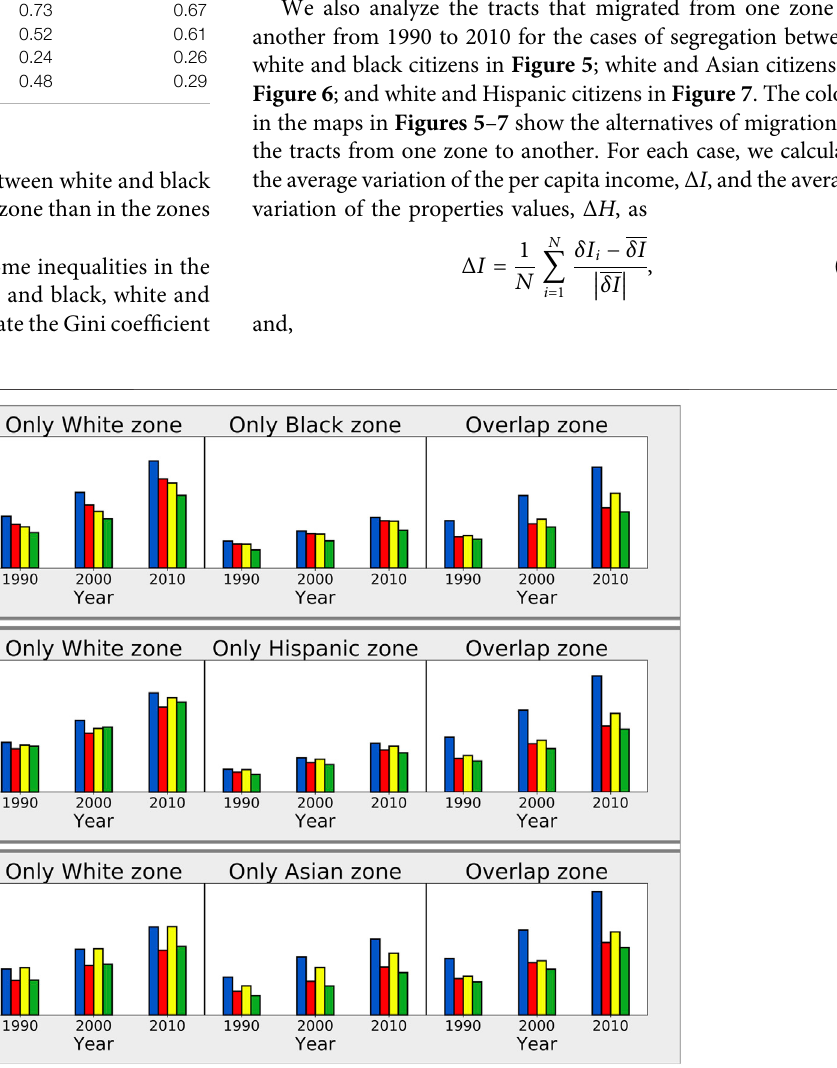
FIGURE3 | Percapita income analysis. The mean per capita incomein US dollars of White citizens compared to the mean per capita income ofBlack citizens (top panel), to the mean per capita income of Asian citizens (middle panel), and to the mean per capita income of Hispanic citizens (bottom panel) for the HD Only zones and Overlap zones. For each zone, the mean per capita income of White citizens (blue bars) is consistently higher than the ones of Black citizens (red bars), Asian citizens (yellow bars), and Hispanic citizens (green bars).